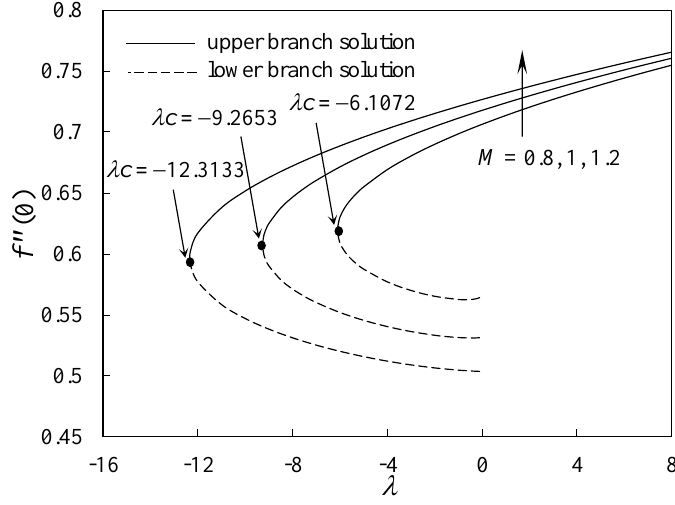
  0 f    0 f  with  for several values of M for Cu-water nanofluid. Figure 14. Variation of f (cid:48)(cid:48) ( 0 ) with λ for several values of M for Cu-water nanofluid. Figure 14. Variation of Figure 14. Variation of with  for several values of M for Cu-water nanofluid.